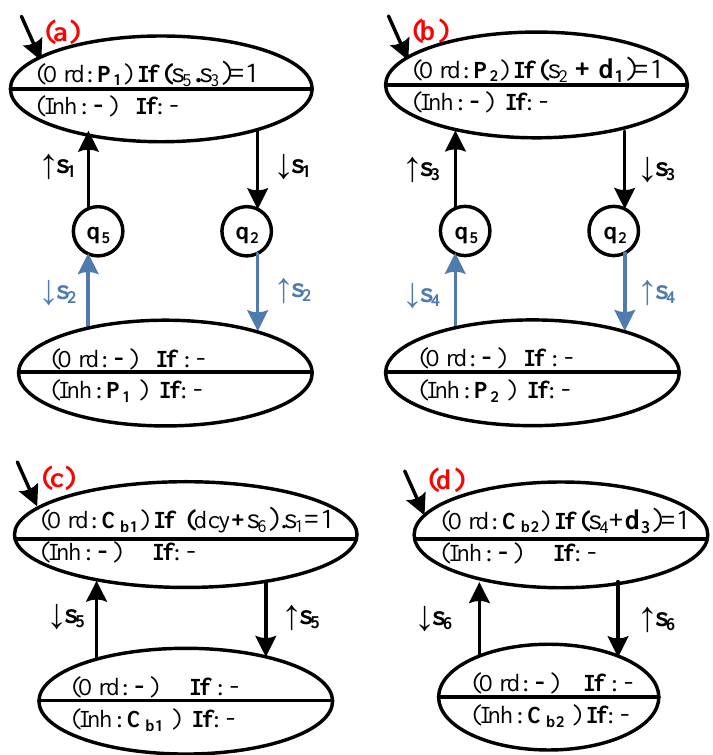
Figure 12. Distributed controllers of the normal behavior of ( a ) P1, ( b ) P2, ( c ) C b1 , ( d ) C b2.